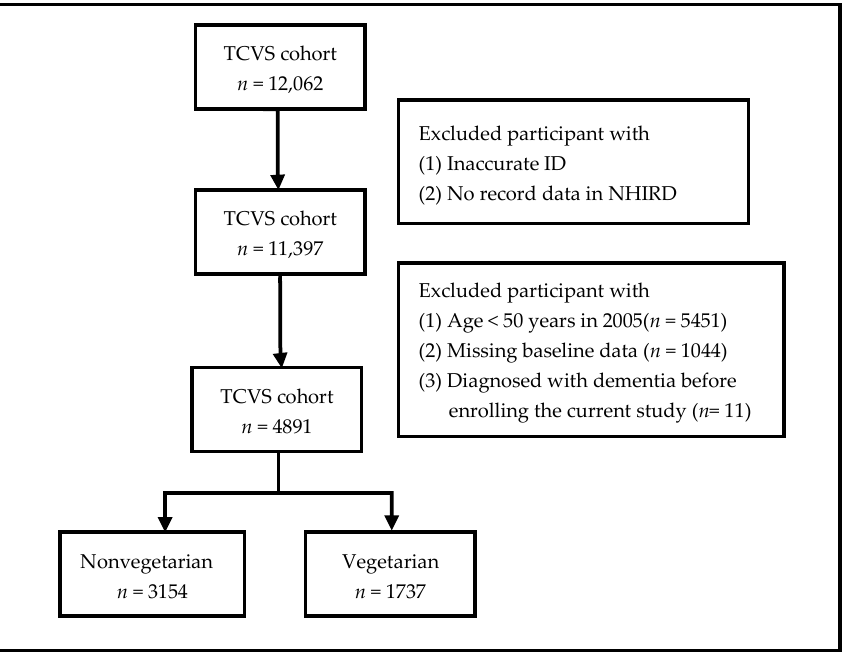
Figure 1. Flowchart of The Study. Abbreviations: TCVS, Tzu Chi Vegetarian Study; ID, the unique national identification number; NHIRD, National Health Insurance Research Database.